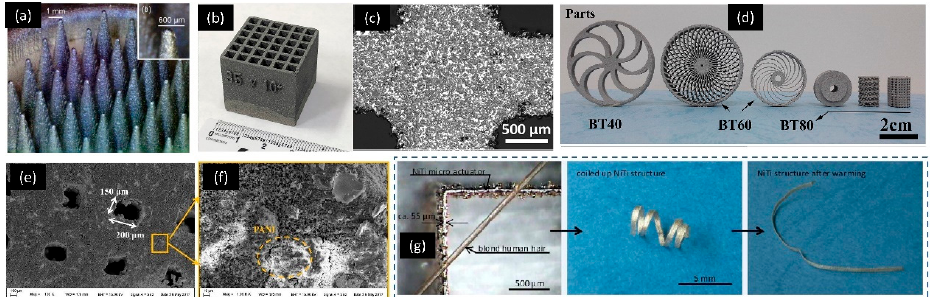
Figure 9. Example of various powder-based 3D-printed electrical and electronic application devices. ( a ) SS 316L monolithic corona ionizer arrays, diameter tip 300 µm. Reproduced with permission from [203]; ( b , c ) PBBJ 3D-printed B4C–Al composites complex collimator, minimum mesh size 1.5